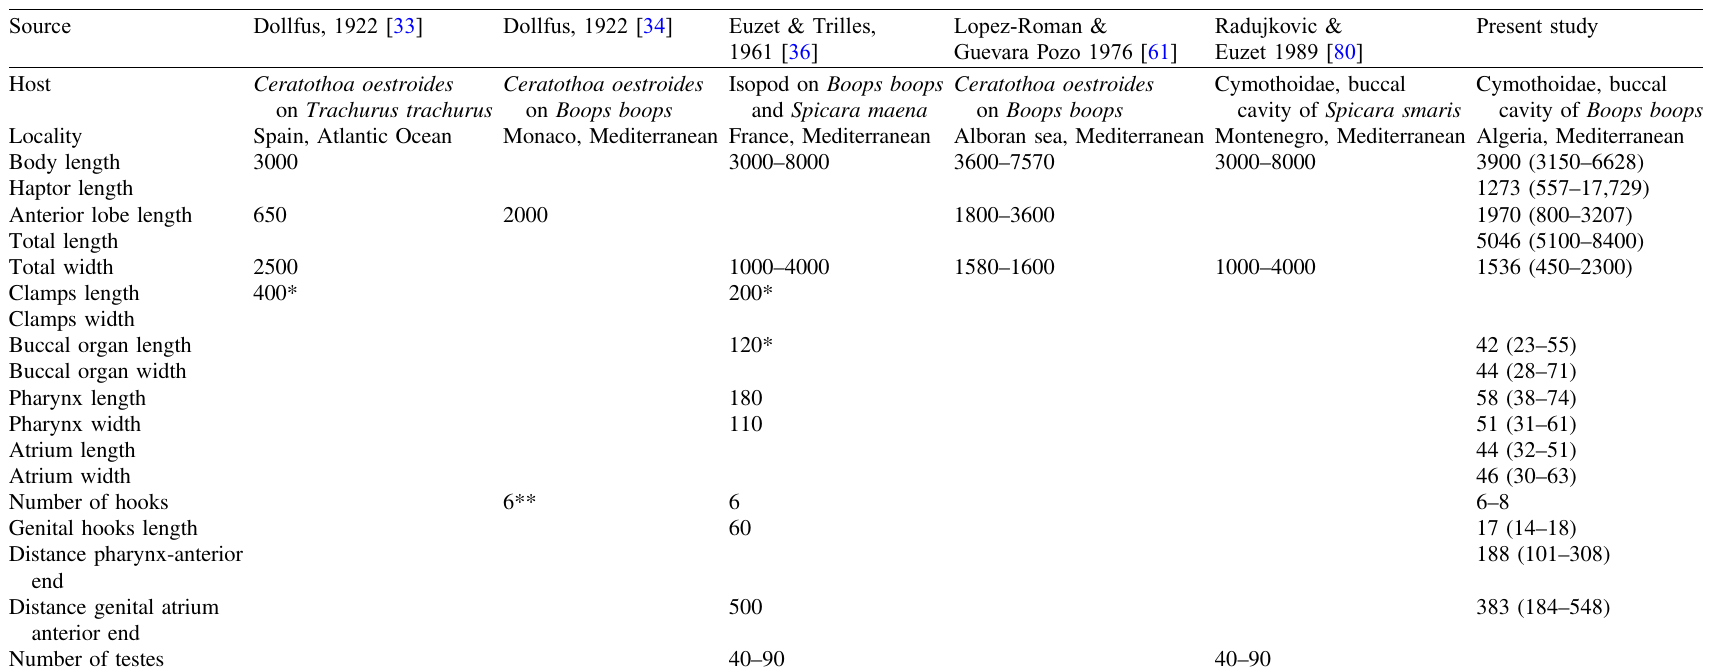
Table 3. Measurements of Cyclocotyla bellones from different hosts and